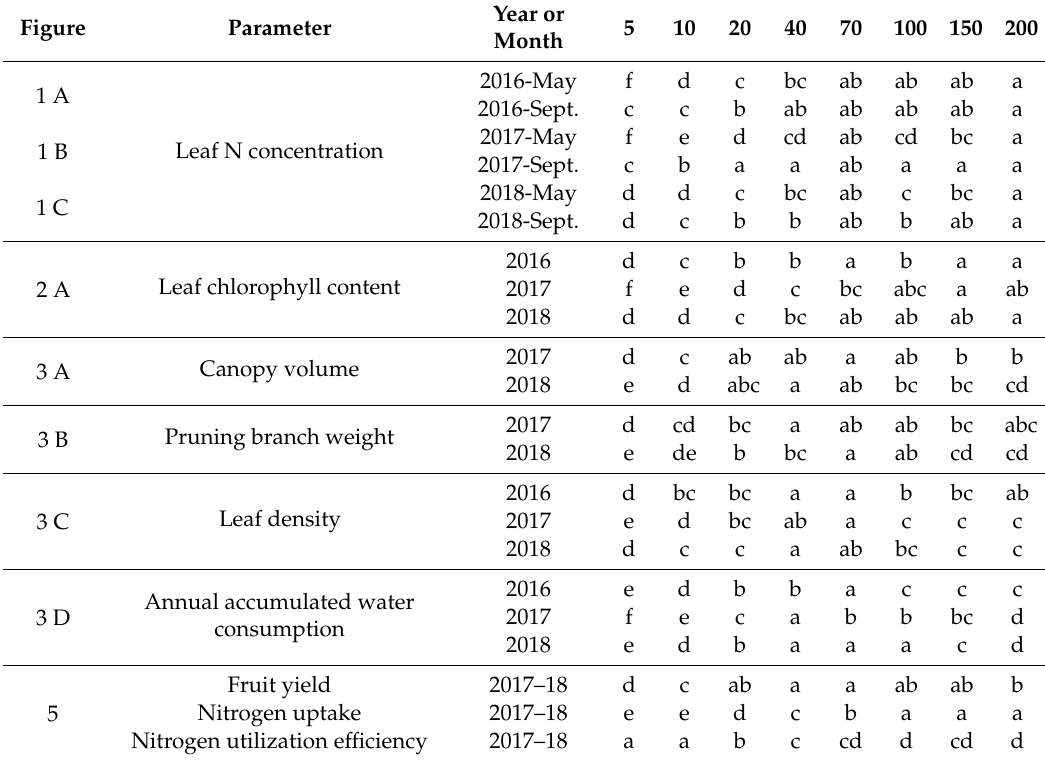
Table A2. Significance for Figures 1–3 and